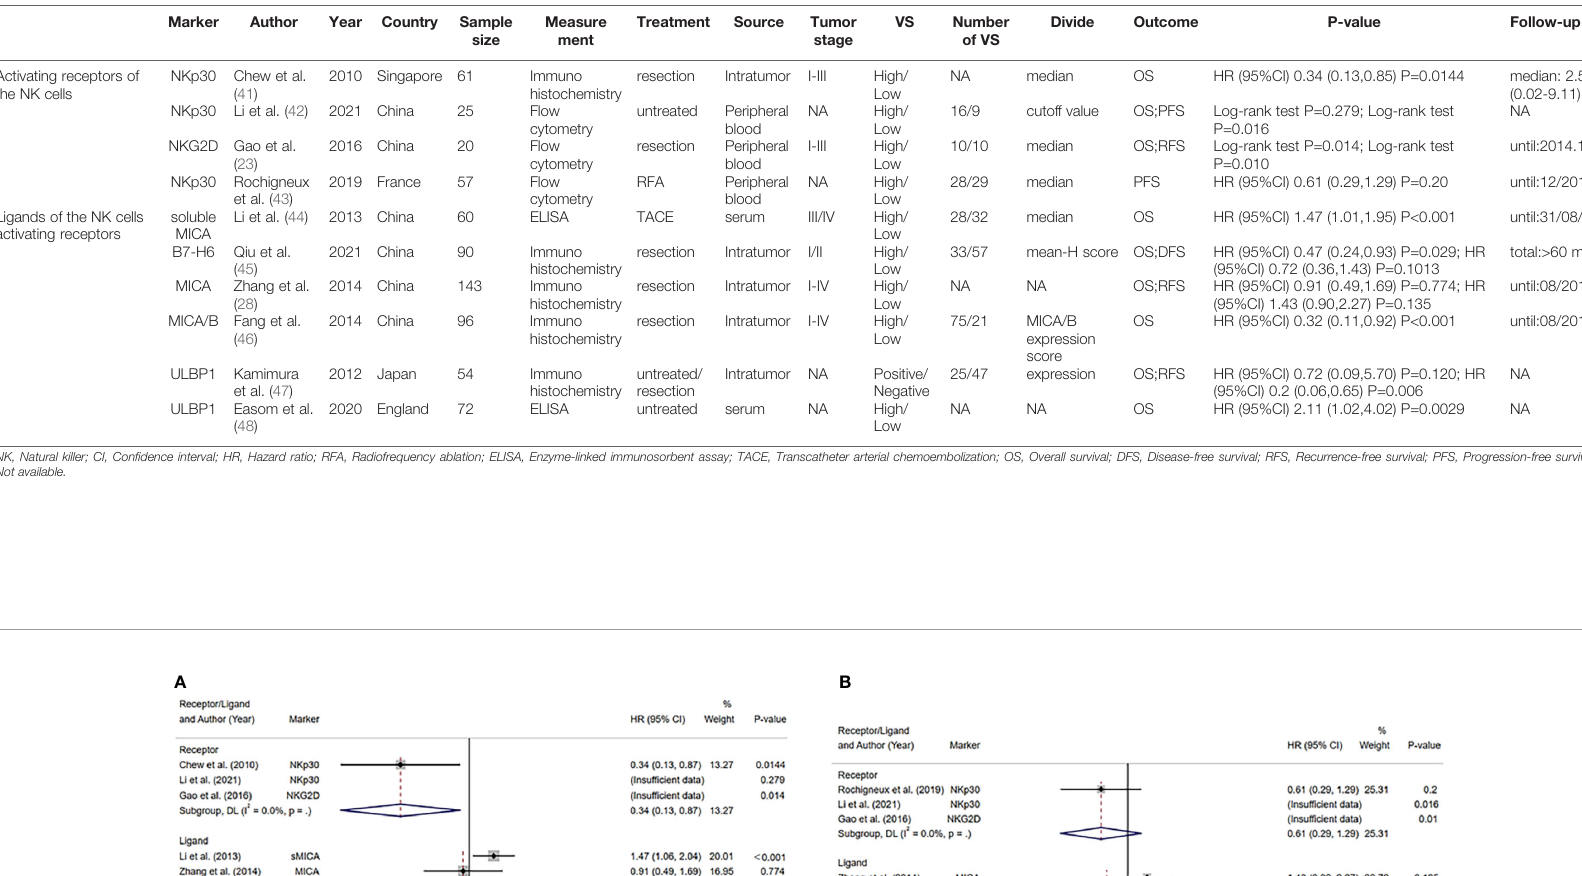
TABLE 3 | The characteristics of included studies about the NK cells activating receptors and their ligands.